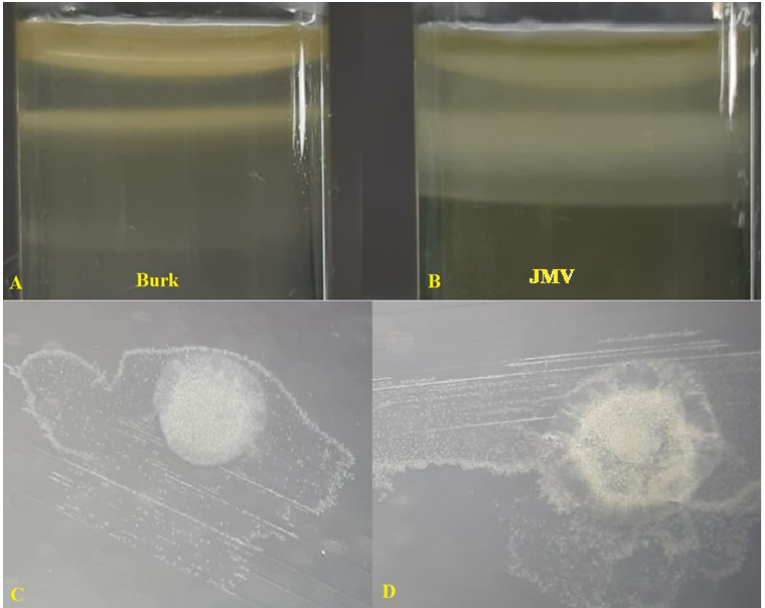
Figure 4. Phenotypic characteristics in semi ‐ solid medium ( A , B ) and morphocolonial characteristics in solid medium ( C , D ) of the Bacillus tequilensis SMNCT 17 ‐ 02 strain grown in two nitrogen ‐ free culture medias.